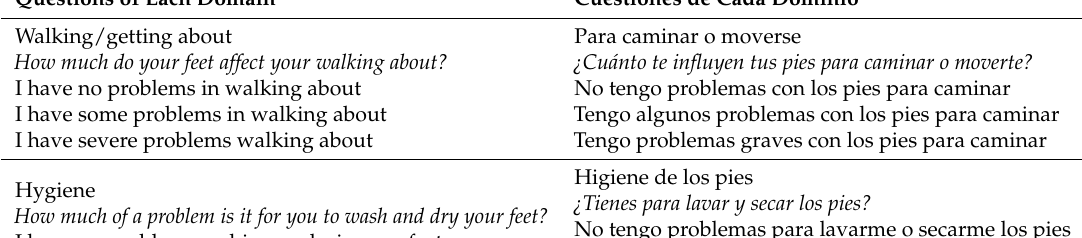
Table 1. Translations between the two versions of the Podiatric Health Questionnaire: PHQ and PHQ-S. Questions of Each